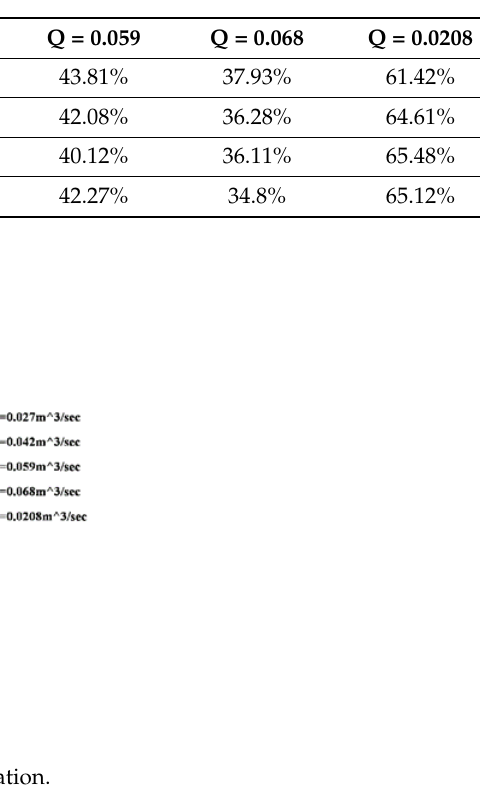
Table 6. Total Energy Dissipation.